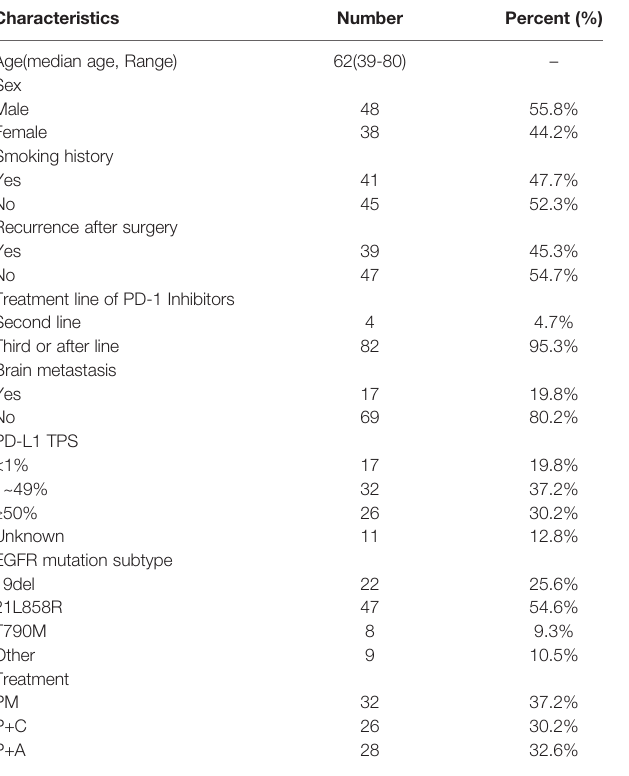
TABLE 1 | Clinicopathological characteristics of 86 EGFR-mutated patients treated with pembrolizumab. Characteristics